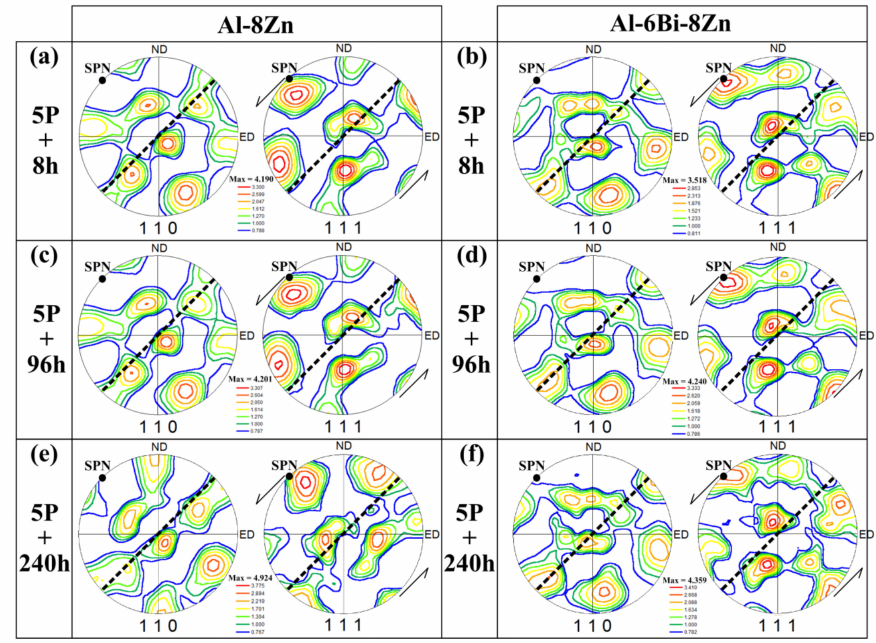
Figure 7. {1 1 0} and {1 1 1} pole figures of ECAP-processed ( a – c ) Al-8Zn alloy and ( d – f ) Al-6Bi-8Zn alloy. The dotted lines indicate the ideal shear plane, and SPN is the shear plane